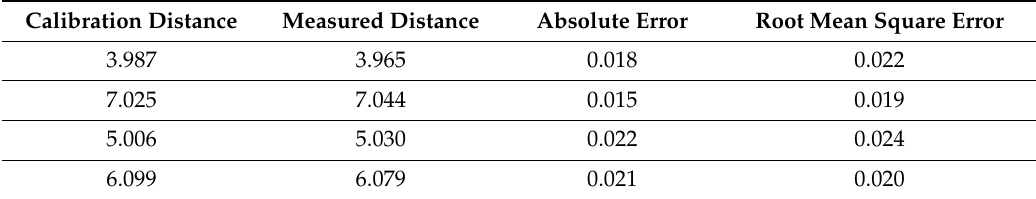
Table 2. Evaluation results for the artificial specular step (units: